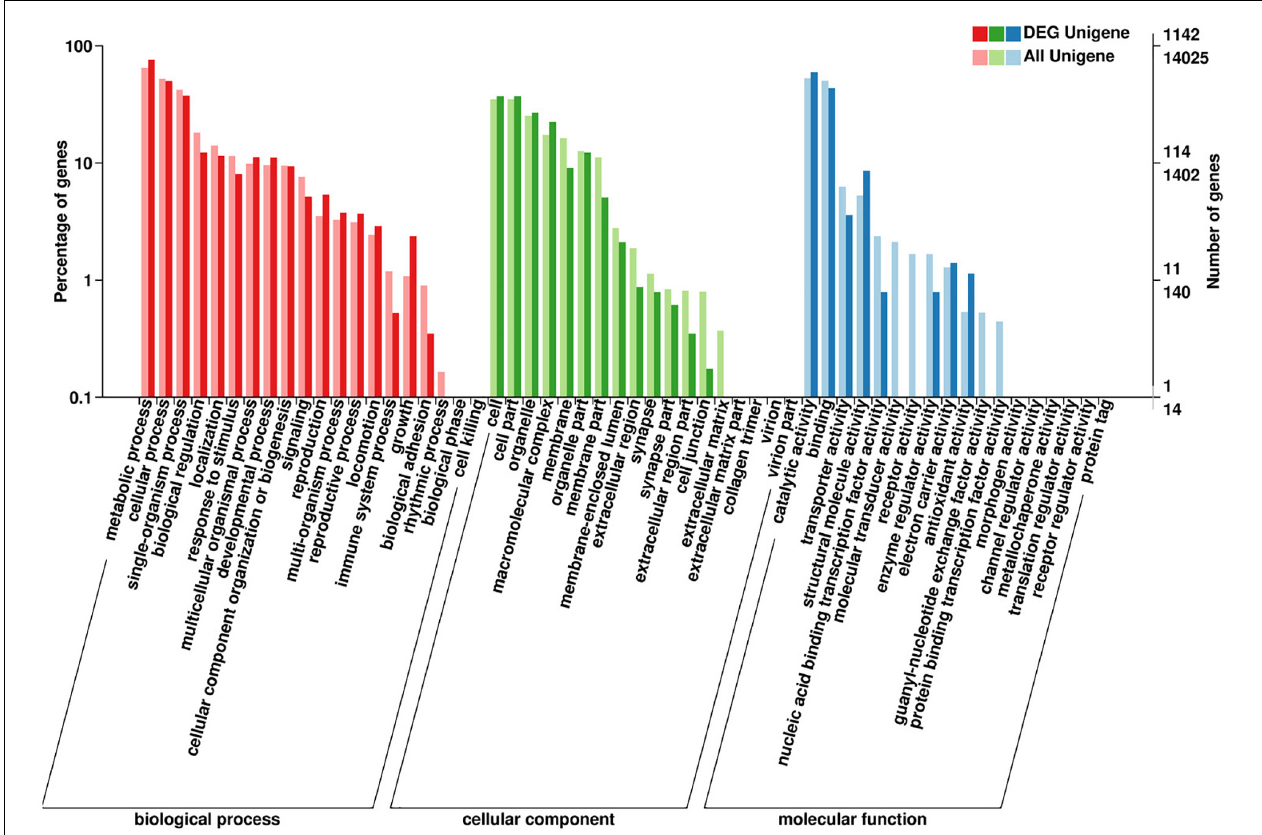
FIGURE 2 | Summary of the annotations of differentially expressed genes in H. axyridis . The GO classifications according to involvement in biological processes, cellular components and molecular functions are